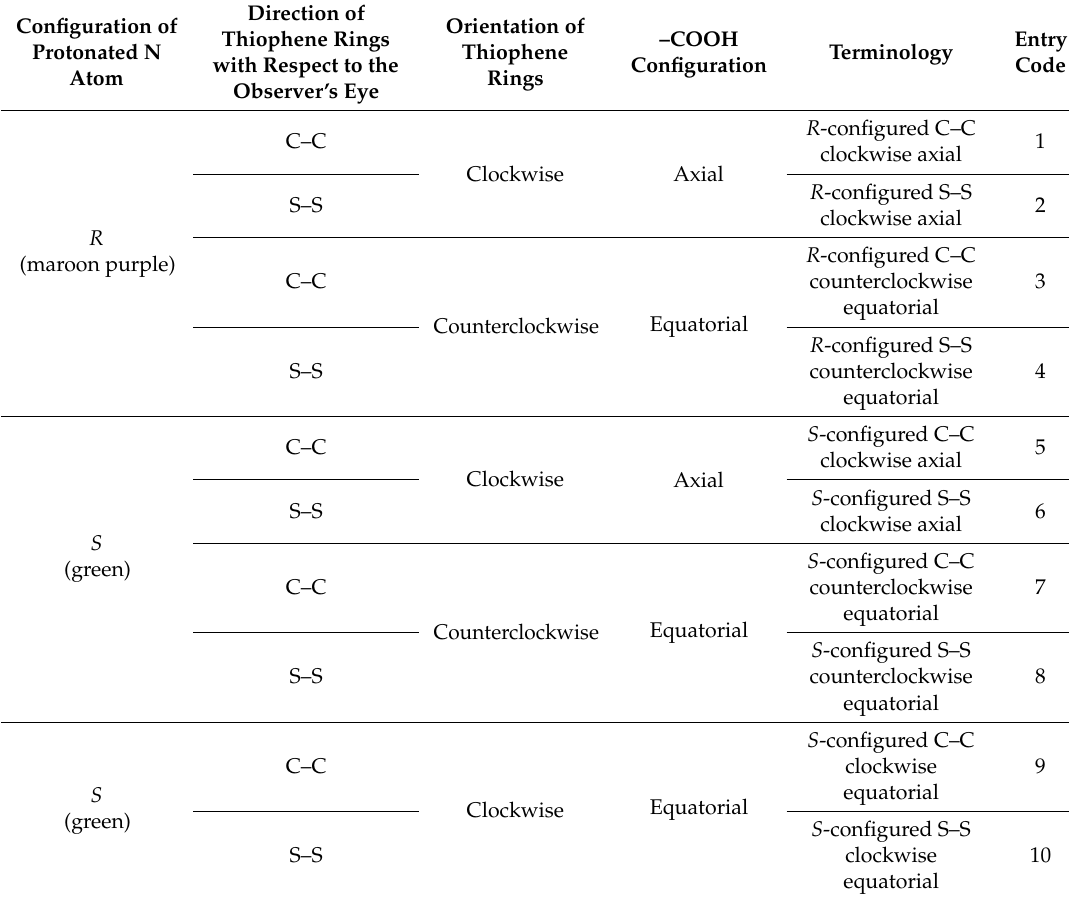
Table 1. R - and S -configured tiagabine enantiomers and the associated terminology for thiophene rings and –COOH group of the piperidine ring. The highlighted entries were selected for molecular dynamics (MD) simulations on the basis of ligand–protein interactions in hGAT1 binding